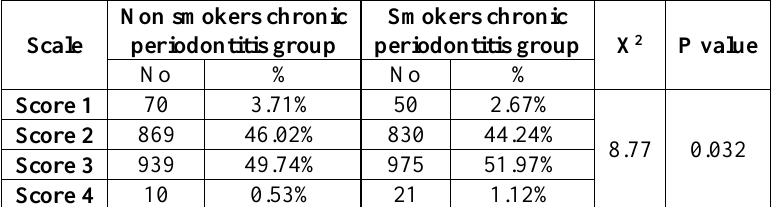
Table 4: Number and percentage (in sites) of CAL scores and Chi-square test of smokers and